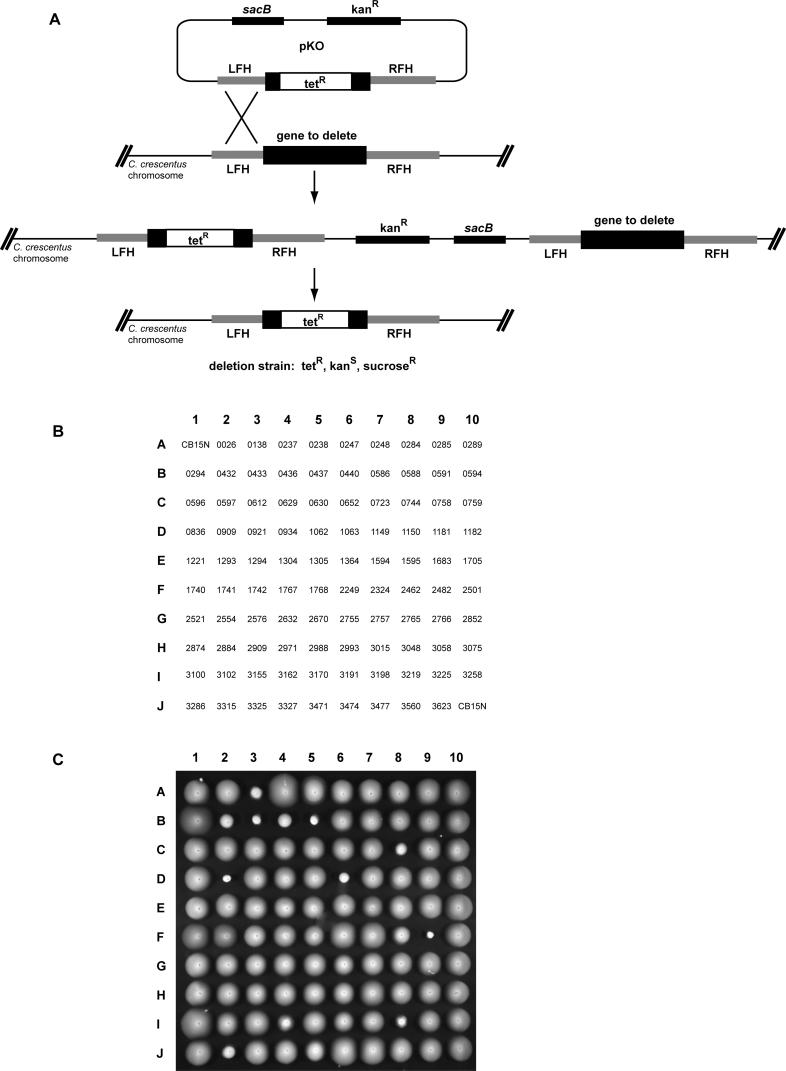
Systematic Deletion of Two-Component Signal Transduction Genes(A) Methodology used to generate chromosomal deletion strains. For each gene to be deleted, a suicide vector was constructed, with approximately 800-bp regions of homology upstream and downstream of the gene flanking a tetR cassette. See Materials and Methods and Figure S1 for details of plasmid construction. In a two-step process, deletion strains are isolated by selecting first for tetracycline resistance and then by sucrose counter-selection utilizing the sacB gene carried on the vector. Cells harboring the sacB gene die in the presence of sucrose. Hence, a deletion strain is identified as tetR/sucroseR. For nonessential genes, stable deletions are easily identified by screening 5–10 colonies after the two-step recombination. For essential genes, no tetR/sucroseR strains can be recovered (see text and Figure S1 for additional details).(B and C) Swarm plate analysis of 97 nonessential two-component deletion strains. (B) Map of strain positions in the swarm plates. Wild-type CB15N is in positions A1 and J10 for comparison to mutant strains. (C) PYE swarm plate after 3 d of growth at 30 °C. Swarm sizes and densities were scored visually and digital images analyzed in Matlab (MathWorks, Natick, Massachusetts, United States). Strains exhibiting swarm plate phenotypes are listed in Table 2, except for ΔCC1221 in position E1, which is deleted for a kinase erroneously annotated as a histidine kinase.